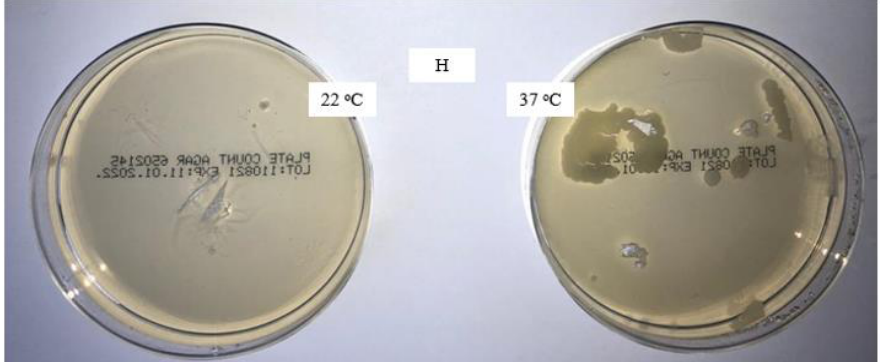
Figure 2. Colonies of aerobic microorganisms on a medical mask after household washing (H 5 × ).